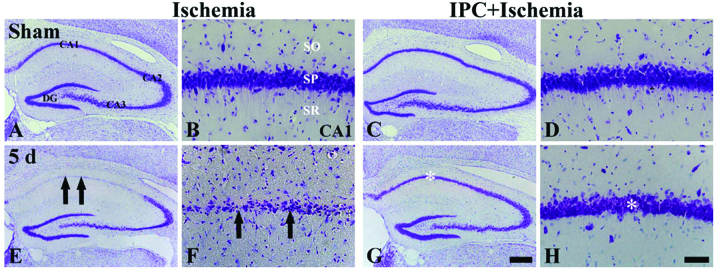
CV staining in the hippocampus of the ischemia-operated (left 2, columns) and IPC + ischemia-operated (right 2 columns) groups at (A-D) sham and (E-H) 5 days (5 d) post-ischemia. CV+ cells (arrows) are damaged in the stratum pyramidale (SP) of the CA1 region only at 5 days post-ischemia in the ischemia-operated group; however, CV+ cells (asterisk) in the IPC + ischemia-operated group were similar to those in the sham-operated group. SO, stratum oriens; SR, stratum radiatum; IPC, ischemic preconditioning; DG, dentate gyrus; CA1, CA2 and CA3 represent regions I, II and III of hippocampus proper, respectively; CV, cresyl violet. Scale bar: (A, C, E and G) 800 μm and (B, D, F and H) 50 μm.